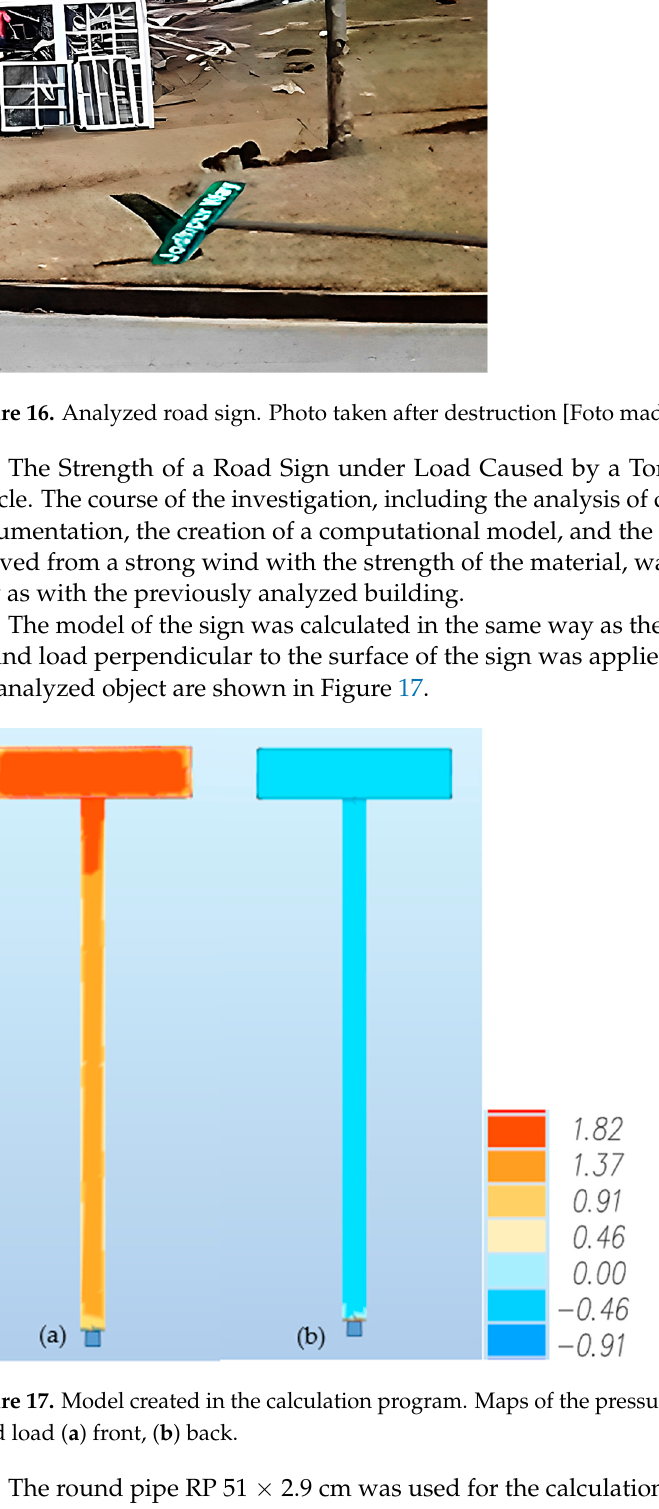
( d ) Figure 18. Obtained results of internal forces: ( a ) shear force, ( b ) bending moments, ( c ) stresses and ( d ) deflections. The profile was checked in the calculation program for damage caused by exceeding the cross-section load capacity, buckling at a wind speed of 49.58 m/s. The sum of the quotients of the internal forces to the bearing capacity 𝑁 (cid:3006)(cid:3031) 𝑁𝑡 (cid:3019)(cid:3031) + 𝑀𝑦 (cid:3006)(cid:3031) 𝑀𝑦 (cid:3030),(cid:3019)(cid:3031) + 𝑀𝑧 (cid:3006)(cid:3031) 𝑀𝑧 (cid:3030),(cid:3019)(cid:3031) = 1.00